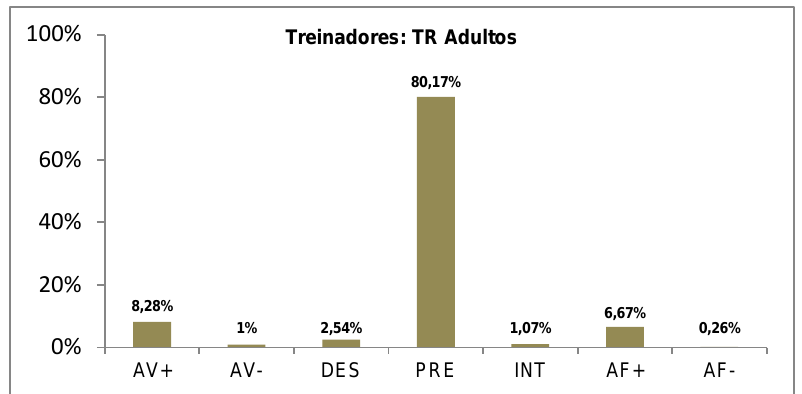
Figura 5. Valores em porcentagem da dimensão objetivo durante a competição (AV+ - Avaliativo Positivo; AV- - Avaliativo Negativo; DES – Descritivo; INT – Interrogativo; AF+ - Afetivo Positivo; AF- - Afetivo